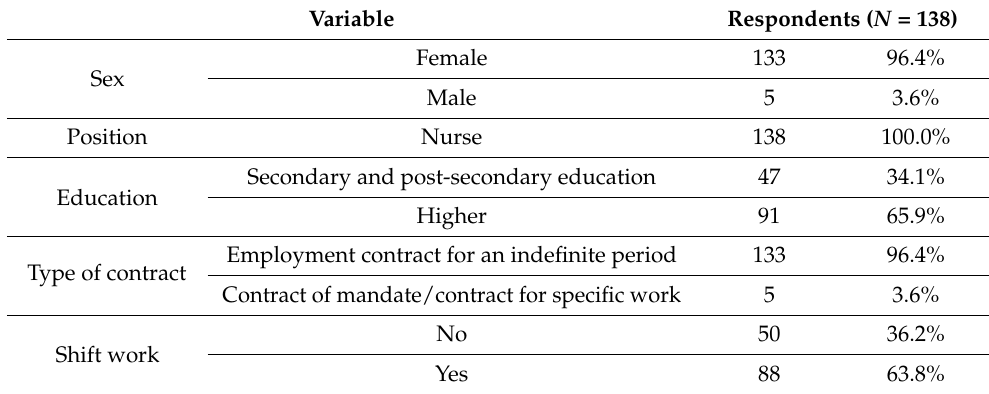
Table 1. Characteristics of the study group of